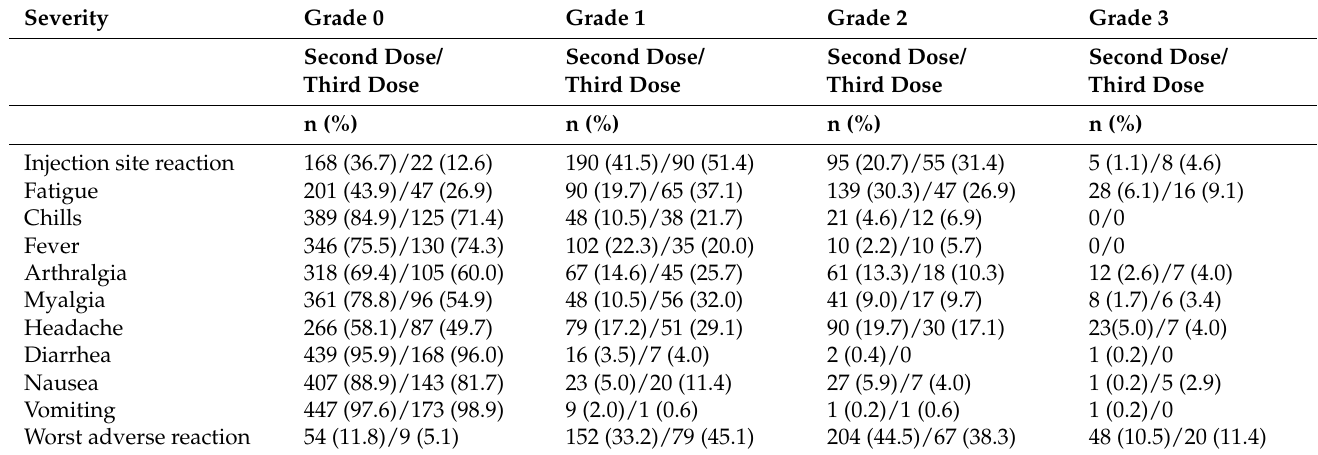
Table 2. Severity of each adverse reaction after the second and third doses of BNT162b2 vaccination.